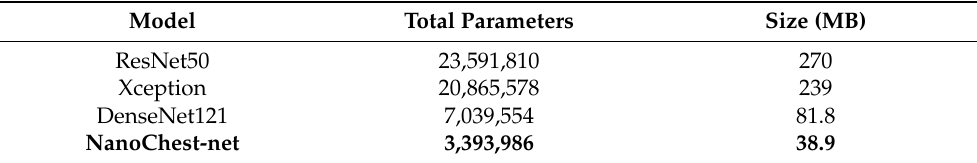
Table 10. Size comparison of the CNN models.